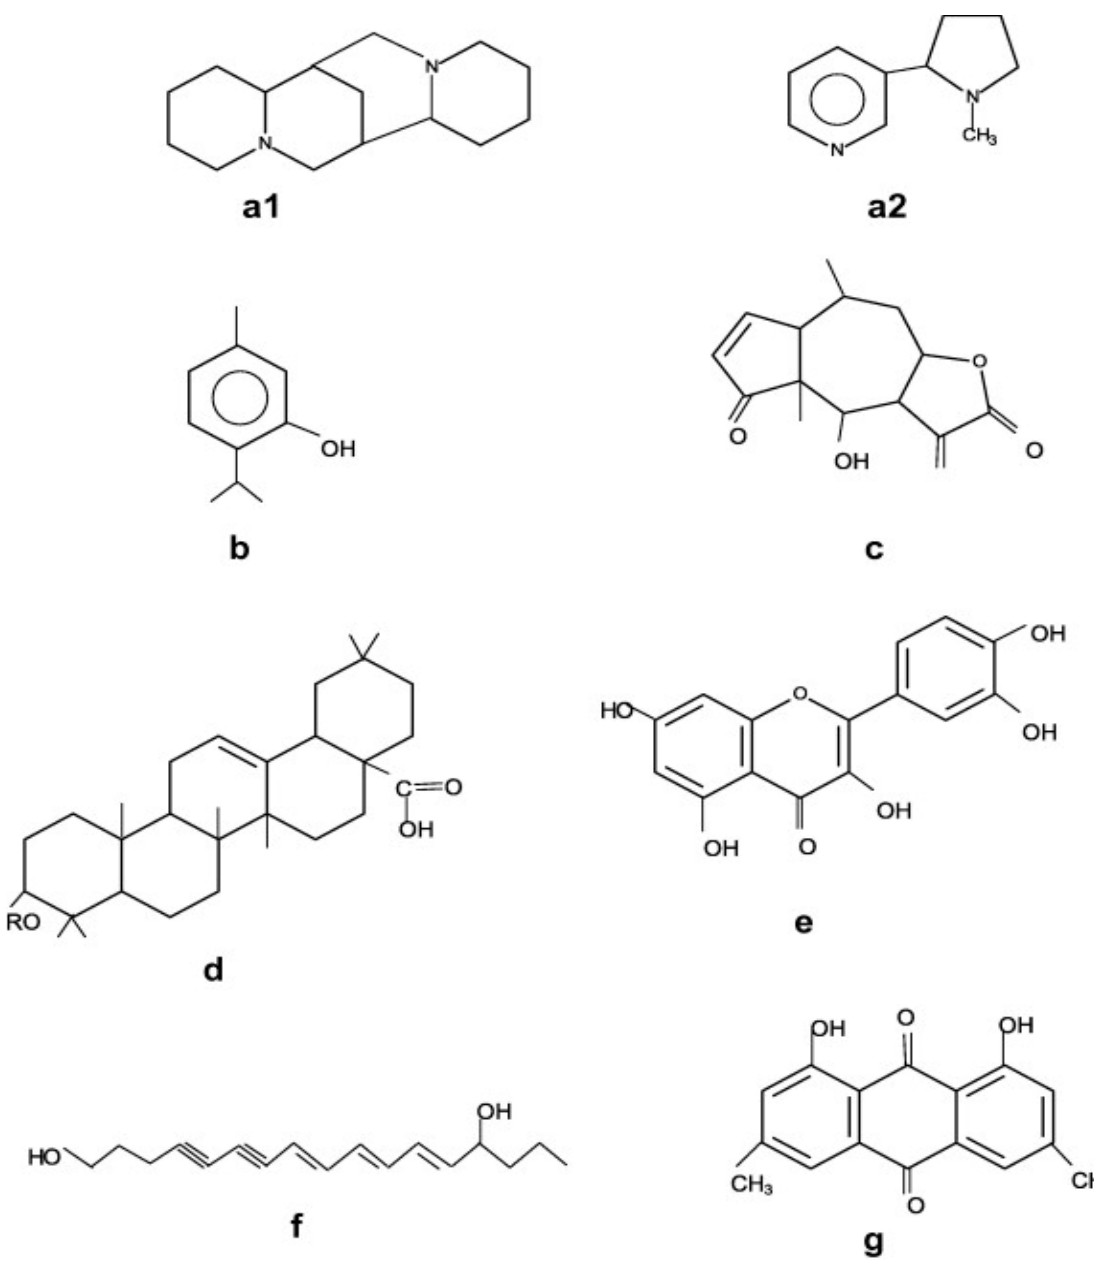
Figure 2. Basic structures of plant bioactive compounds alkaloids ( a1 , a2 ), monoterpenes ( b ), sesqueterpenes ( c ), triterpenes, saponins, steroids ( d ), flavonoids ( e ), polyacetylenes ( f ), polyketides ( g ) (Adopted with permission from Wink et al. [9].